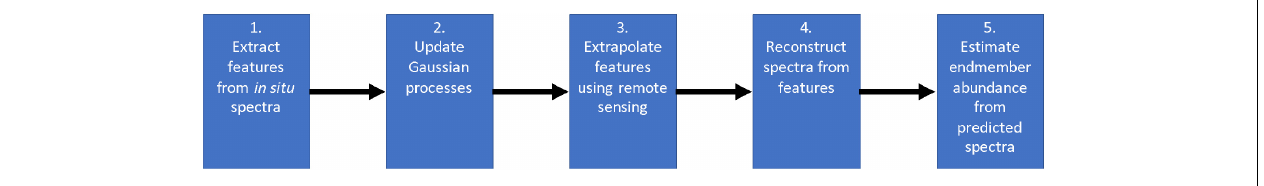
FIGURE 5 | Active coral reef mapping